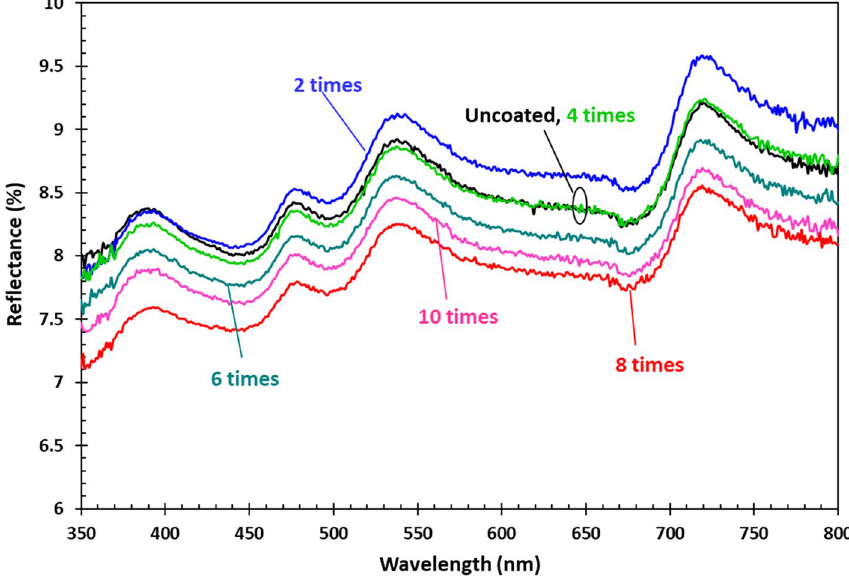
Figure 4. ( a ) Reflectance of the uncoated and the coated sparking titanium on the glass cover of the PV panels. ( b ) Transmittance of uncoated and coated specimen. The inset shows a magnification of the data.